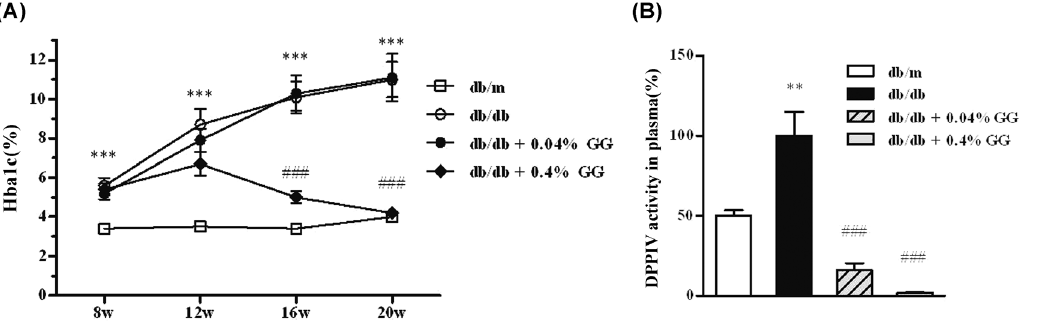
Fig 1. The effect of gemigliptin on HbA1c levels and plasma DPPIV activities in db/db mice. HbA1c levels in the plasma (A). Plasma DPPIV activities in db/m, db/db, and db/db mice treated with 0.04% (w/w) or 0.4% (w/w) gemigliptin (B). All results are expressed as means ± SEMs. ** p < 0.01, *** p < 0.001 vs. db/m; ###p < 0.001 vs.